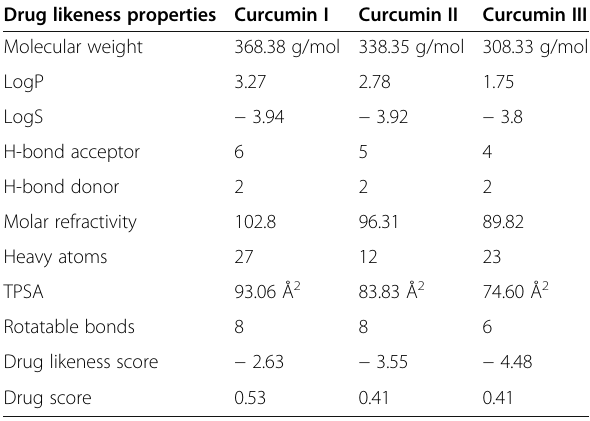
Table 2 Result of drug likeness property analysis of curcumin I (PubChem CID: 969516), curcumin II (PubChem CID:5469424), and curcumin III (PubChem CID: 5315472). Lipinski ’ s rule of five: molecular weight : < 500, number of H-bond donors: ≤ 5; number of H-bond acceptors: ≤ 10; lipophilicity (expressed as LogP): < 5; and molar refractivity: 40 – 130